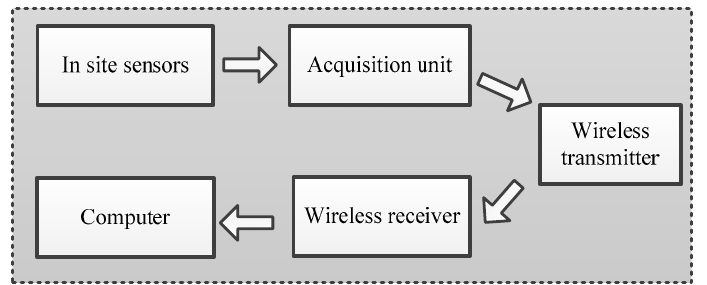
Figure 2. A framework of data acquisition and transmission sub-system.